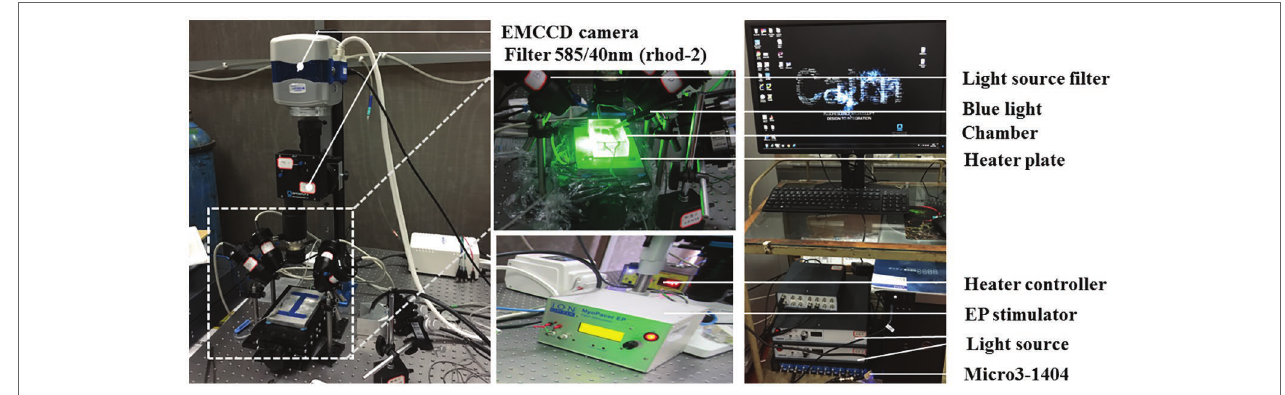
FIGURE 1 | The optical imaging system. Two green (a peak wavelength of 530 nm) and two red (a peak wavelength of 627 nm) LED lights (Cairn Research, Faversham, Kent, UK) were placed around the chamber so as to uniformly illuminate the SAP. The green LEDs were fitted with excitation bandpass filters (S555/25X, Chroma Technology GmbH, Germany), and the red LEDs were fitted with excitation bandpass filters (HQ640/50, Chroma Technology GmbH, Germany) to efficiently select the best excitation wavelength range for Rhod-2 AM and Di-4-ANBDQPQ, respectively. A multi-bandpass emission filter (ET595/50 + 700LP, Chroma Technology GmbH, Germany) was placed in front of the camera lens to avoid bleed-through of the excitation light and to selectively let the fluorescence emission pass through. A multi-stream light switcher (Cairn Research, Faversham, Kent, UK) was set up to automatically switch between the red and green LED lights in accordance with the frame rate of the camera. Signal recording using this setup is in such a way that one frame data recorded will have only the red light turned on (thereby recording voltage signal alone) and the next frame data recorded will have only the green light turned on (thereby recording CaT signal alone), and the process is repeated until the desired number of frames are